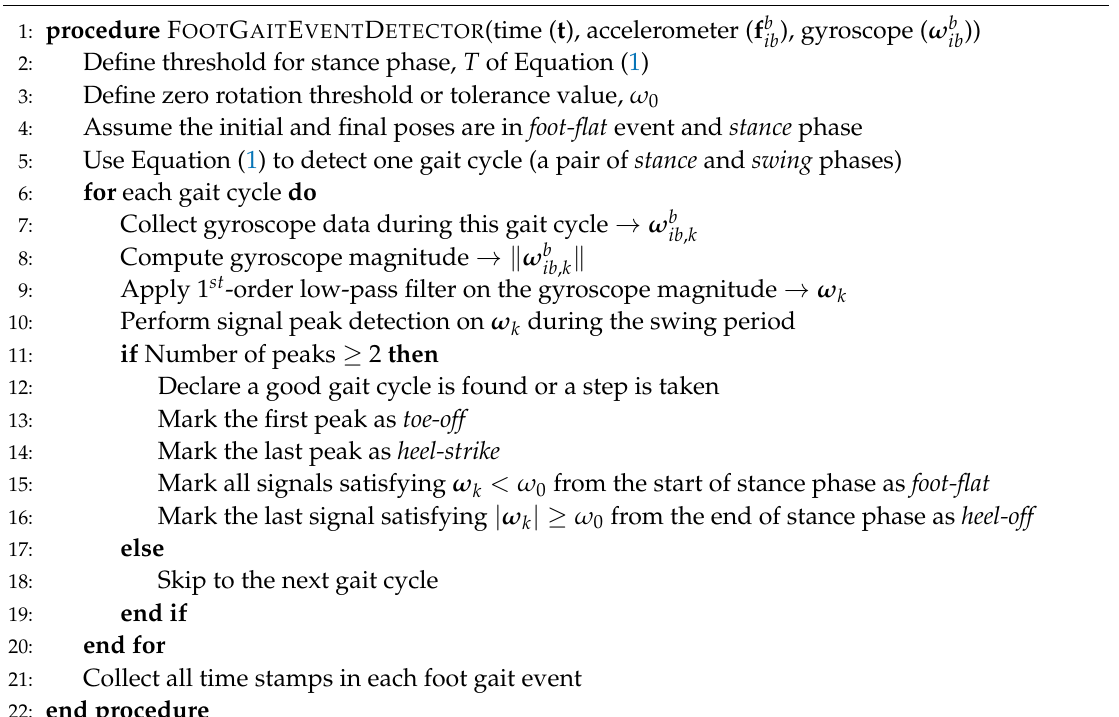
Algorithm 1 Foot gait event detection